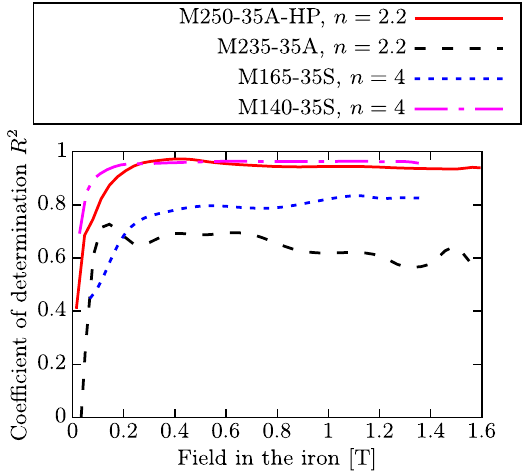
20. Coefficient of determination R 2 for different steel grades over excitation